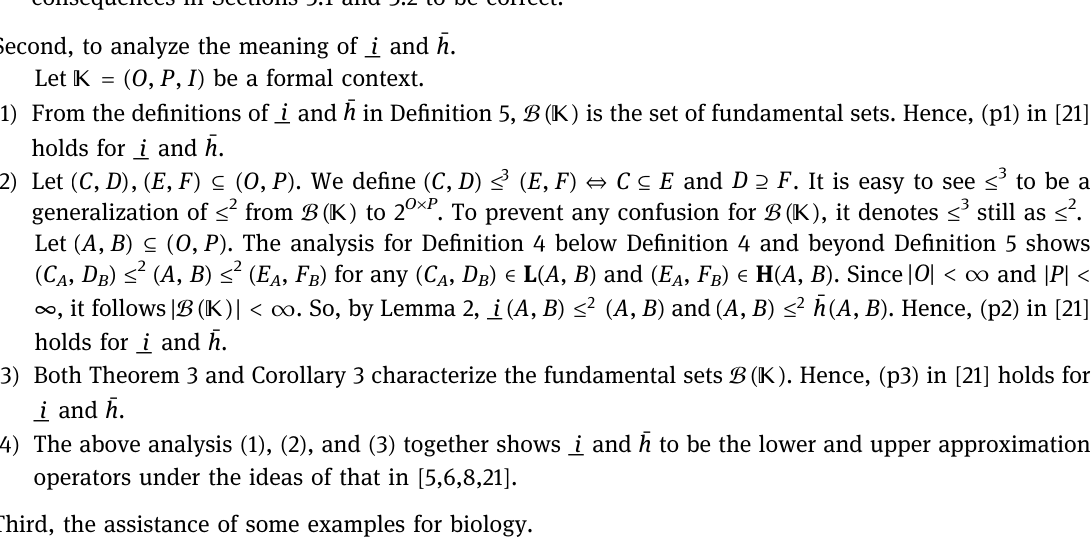
Table 2: A formal context (cid:2) 2